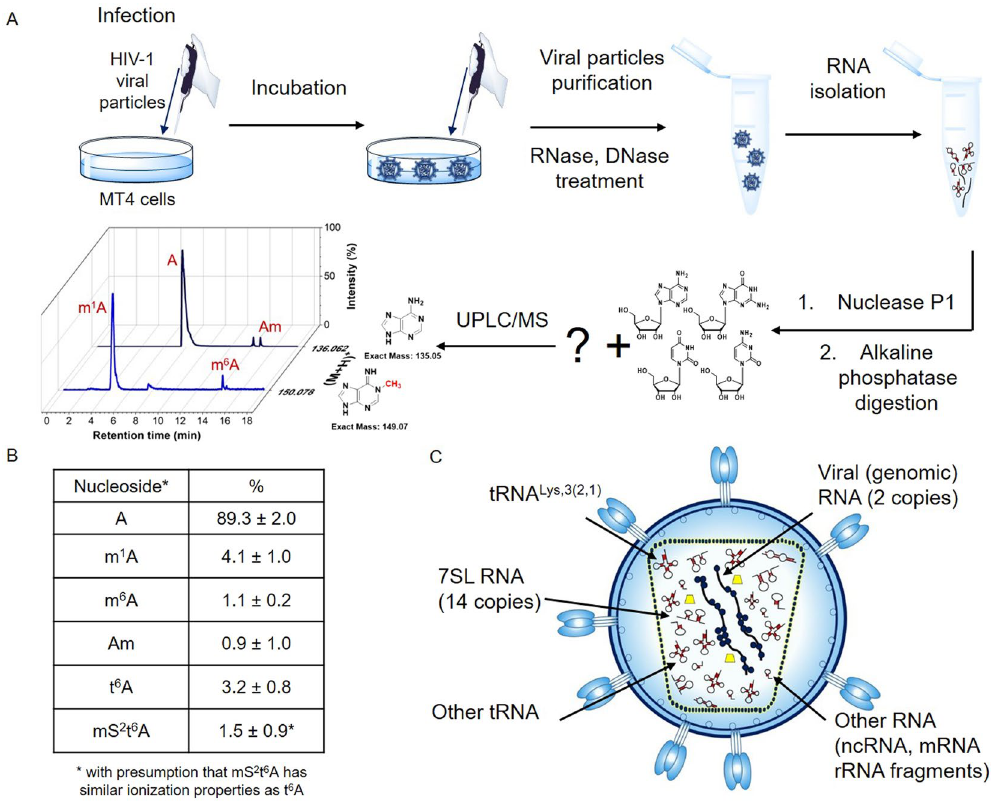
Figure 1. LC/MS analysis of RNA in the HIV-1 packageome. ( A ) Scheme showing the preparation of HIV-1 samples for LC/MS analysis. ( B ) Ratios of nucleosides in the HIV-1 samples as analysed by LC/MS using biological tetraplicates. ( C ) A schematic view on the RNA composition in